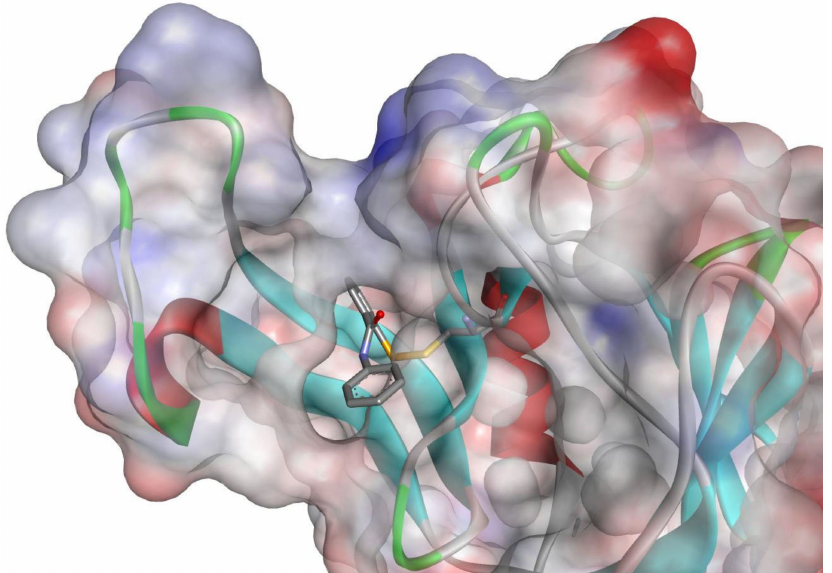
Figure 3. Binding mode of ebselen with L , D -transpeptidase 2 of M. tuberculosis (PDB: 6RRM). The inhibitor reacted with Cys354 in two